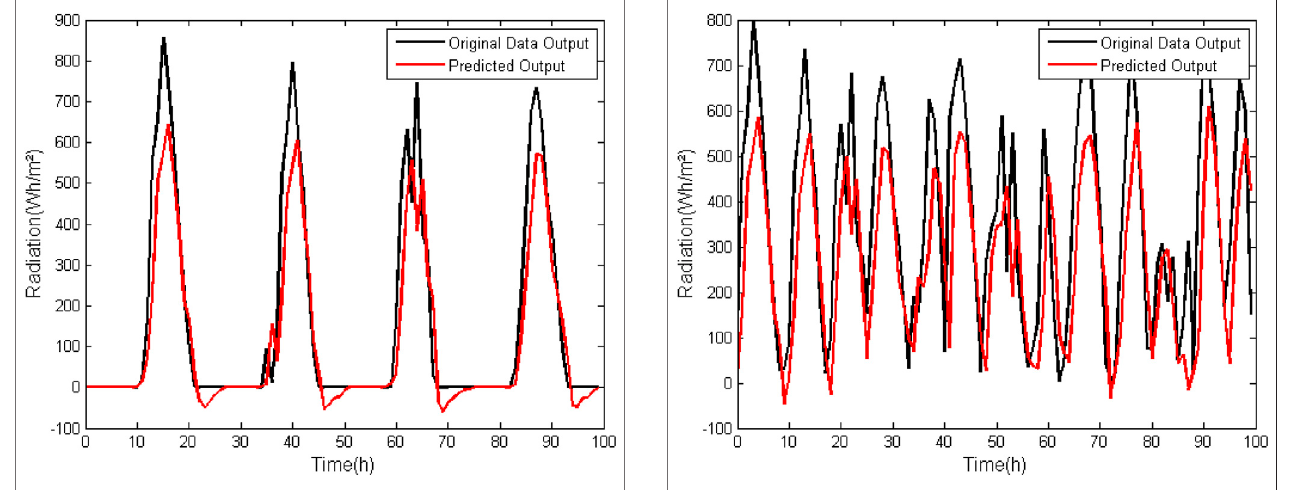
FIGURE 5 | ARX model (na = 4, nb = 4, nk = 1) for prediction of normal direct radiation data without suppression of zero.